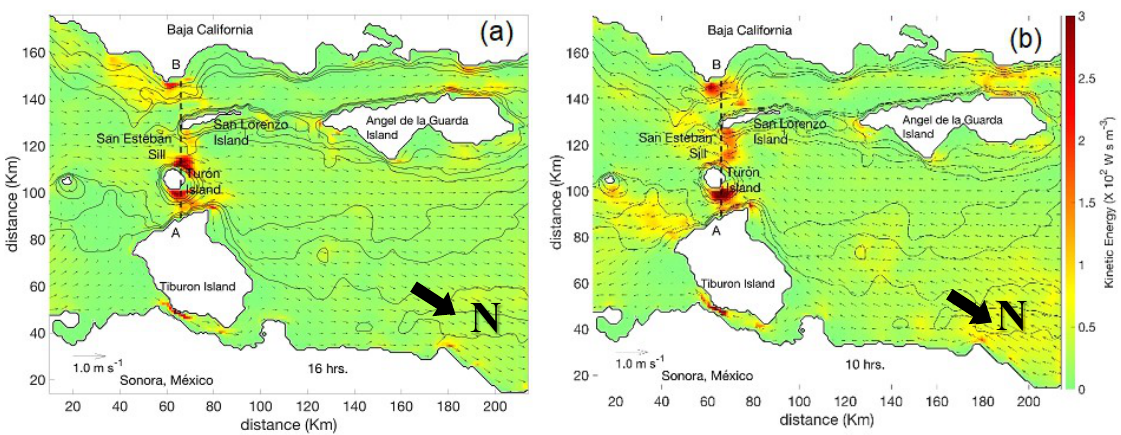
Figure 4. Maps of eddy kinetic energy and vertical integrated velocity in the Gulf of California Great Island Region for tidal inflow ( a ) and tidal out flow ( b